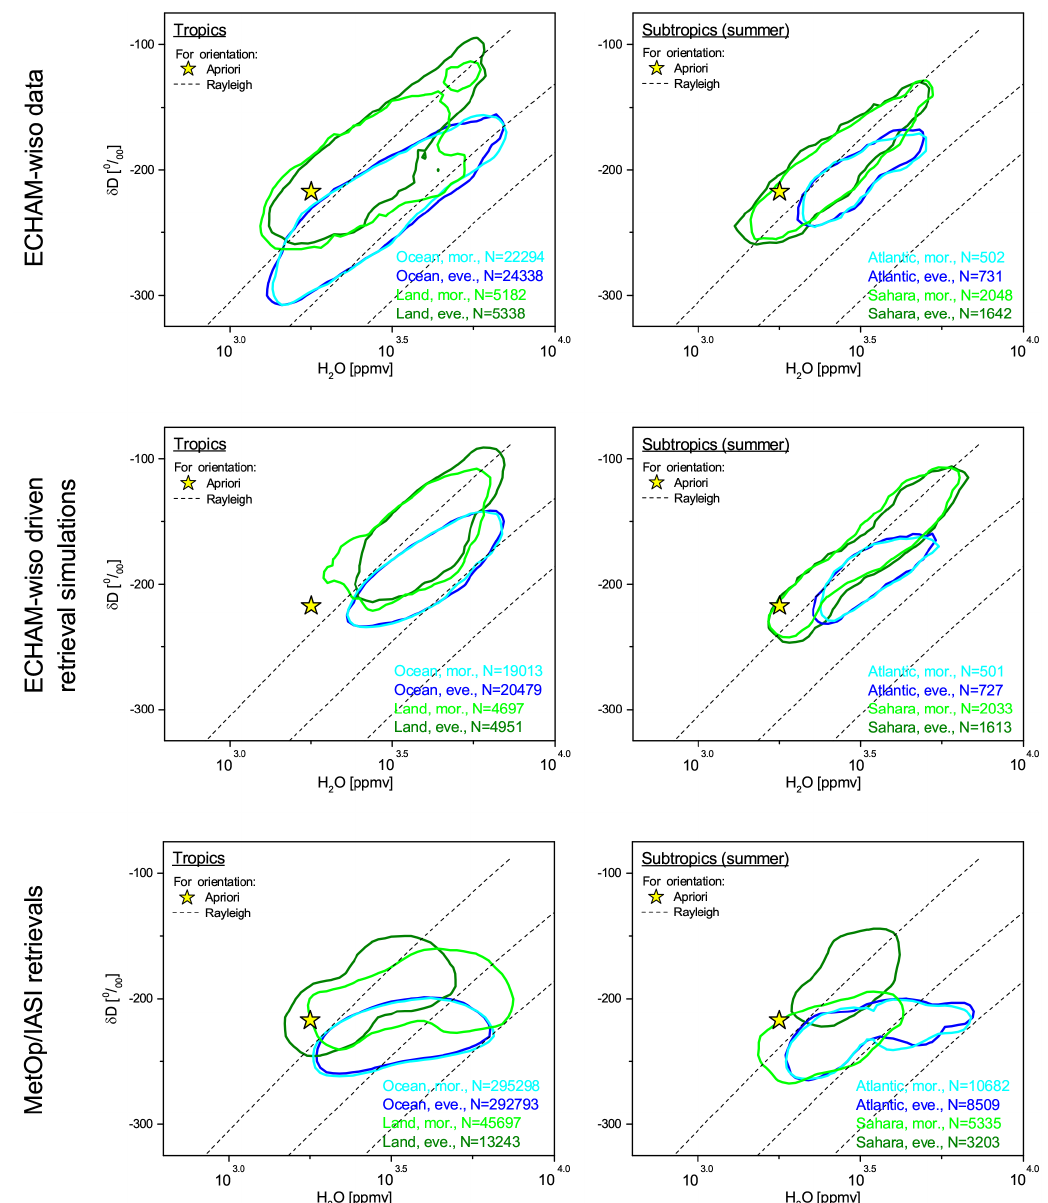
Figure 12. Diurnal-scale signals in the {H 2 O, δ D} pair distribution for different scenarios. From the top to the bottom as in Fig. 11: dis- tributions obtained from ECHAM-wiso simulations, from ECHAM-wiso simulations after passing through the retrieval simulator and from the MetOp/IASI retrievals, respectively. Left panels for land and ocean scenarios in the tropics (February + August, 10 ◦ S–10 ◦ N) and right panels for the summertime subtropics (August, 22.5–35 ◦ N) over the central Atlantic (30–50 ◦ W) and the Sahara/Arabia (10 ◦ W–50 ◦ E). The different colours represent the different day times (morning, 06:00 to 12:00LT, and evening, 18:00 to 24:00LT) and scenarios as given in the legend. The black dashed lines represent the same Rayleigh curves as in Fig. 11.